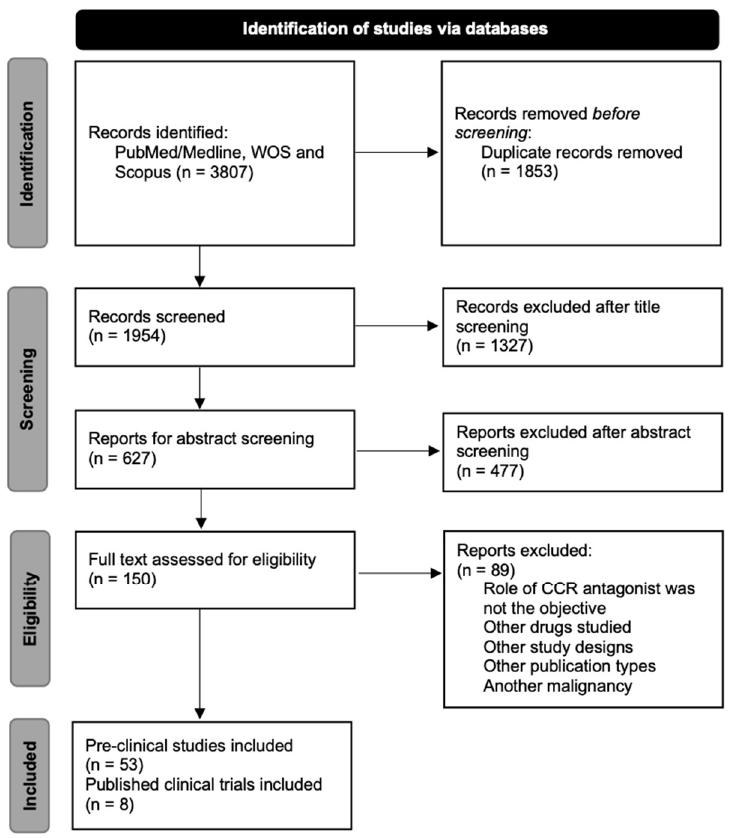
Figure 1. Flow diagram of the systematic selection of the studies.